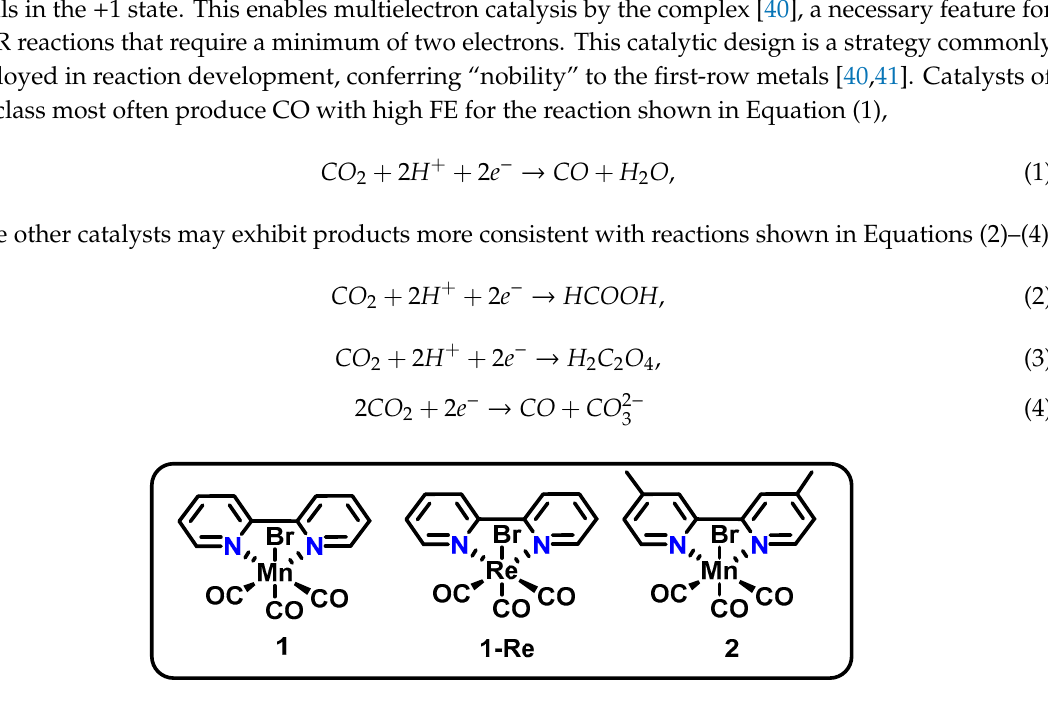
Figure 1. Structures of fac -Mn(bpy)(CO) 3 Br ( 1 ) and fac -Mn(dmbpy)(CO) 3 Br ( 2 ).